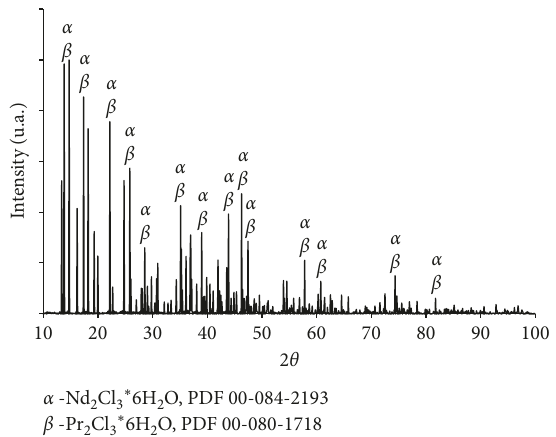
Figure 6: X-ray diffractogram of rare earth chlorides from per- manent magnets.